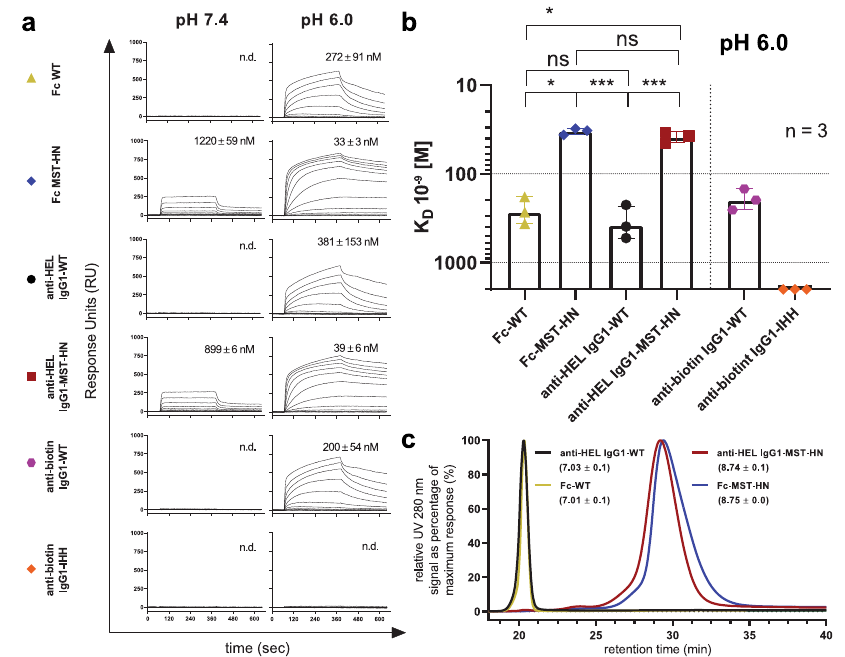
Fig. 1 | No differences in FcRn af fi nity using SPR and elution pH using FcRn- af fi nity chromatography between full-size IgG1 and Fc only. a Examples of sensorgrams of binding of IgG variants and indicated Fc fragments to FcRn as measured by SPR at pH 7.4 or 6.0. IgG variants were coupled to the SPR-array at a range of concentration (7.5, 15, 30, and 60nM; shown is 60nM for anti-biotin IHH and 15nM for allother variants), with solubleFcRn injected from 0.49to 1000nM, representedbythedifferenttraces.Thenumbersindicateaveragedmean K D values for three independent experiments, and the corresponding standard deviations in (nM) were calculated by performing an equilibrium analysis and fi tting a 1:1